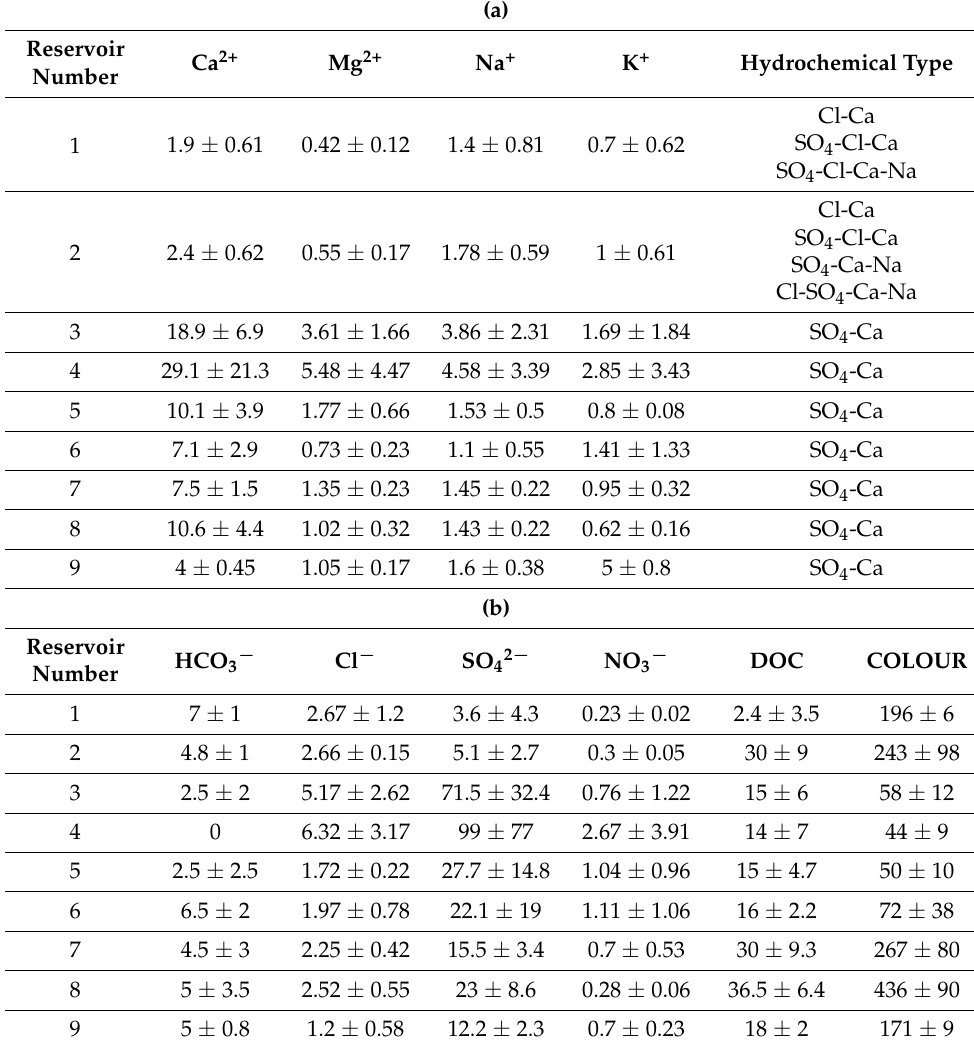
Table 2. ( a , b ) Chemical composition of water in the studied reservoirs [mg/L] (mean, standard deviation; n =